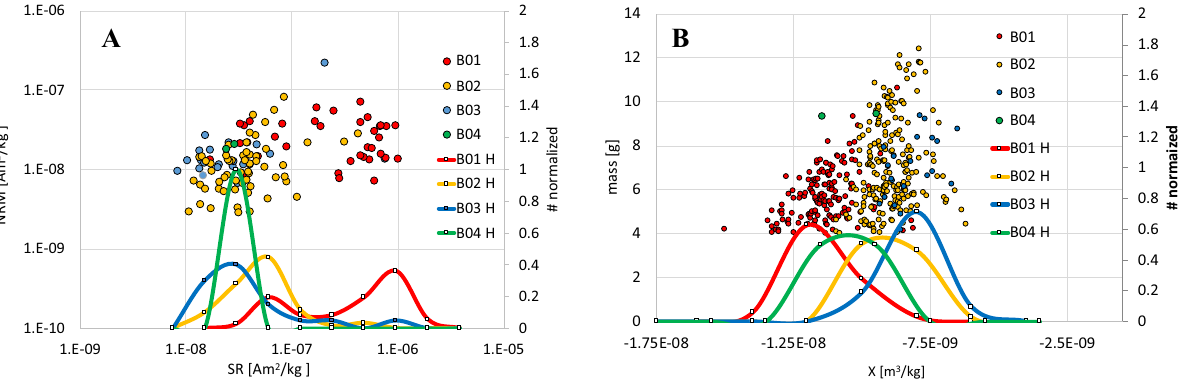
Figure 1. Magnetic characterization of oriented brain subsamples along with histograms. ( A ) Natural remanent magnetization and saturation remanence for the ND brains (B01, B02) and brains without ND (B03, B04) along with the frequency distribution normalize to number of samples. ( B ) Mass of the samples is plotted against magnetic susceptibility X for the brains B01, B02, B03, and B04 along with the frequency distribution normalized to number of